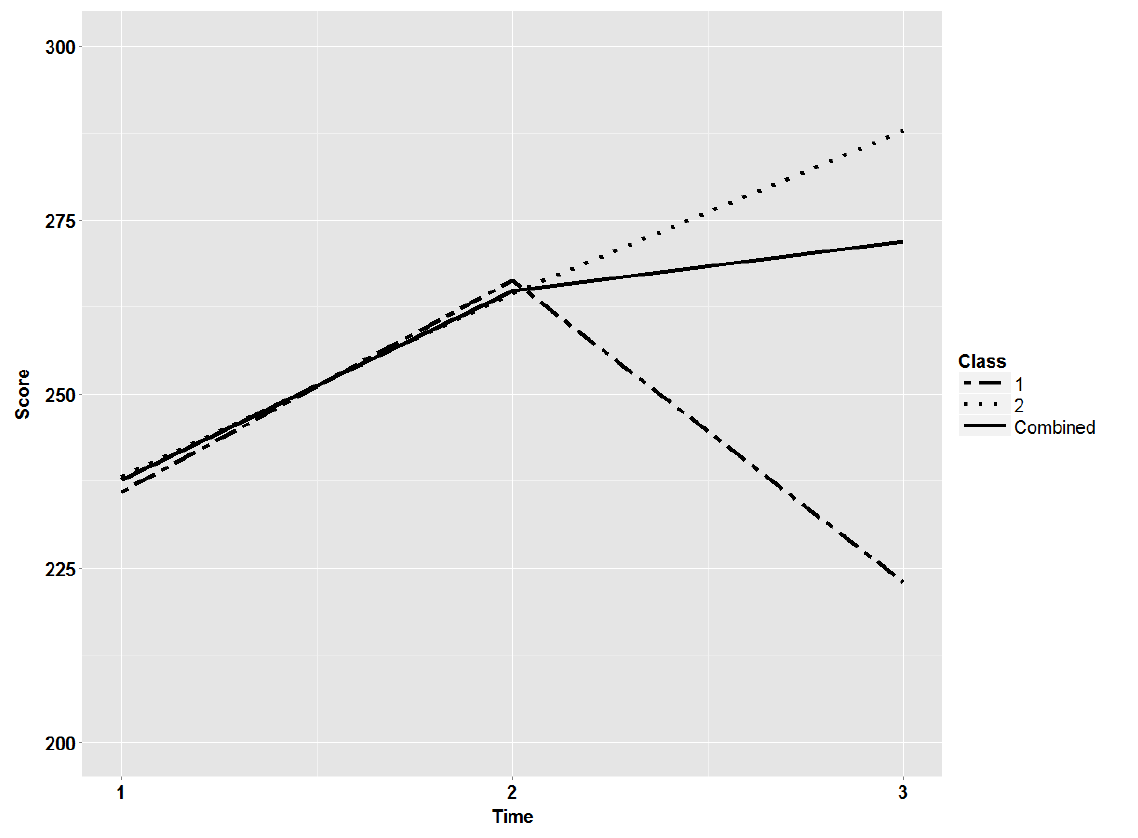
Figure 3. Class-specific and combined growth patterns from matched respondents collected from three waves of Estonian National Intelligence Test scores.